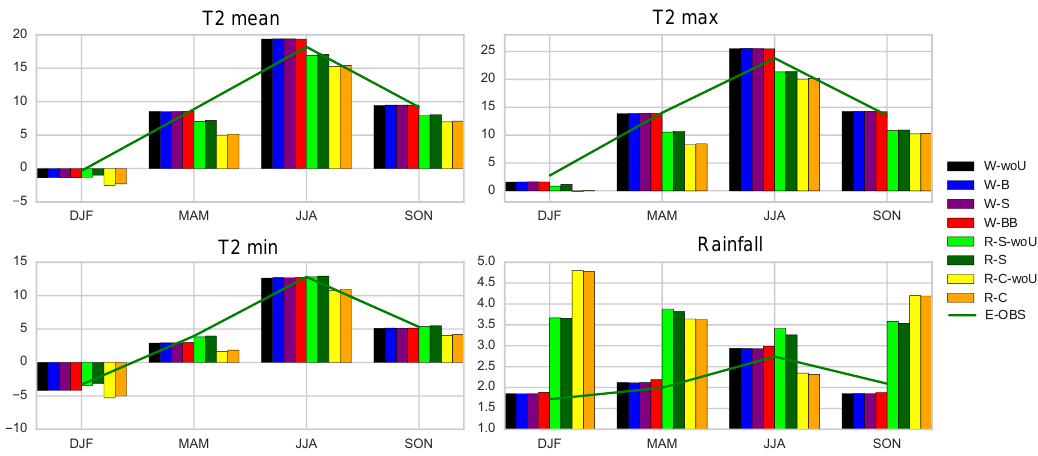
Figure 3. Averaged seasonal modelled temperatures (in ◦ C) and precipitation (mm) for individual model simulations: black – WRF–woU, blue – WRF–BULK, purple – WRF–SLUCM, red – WRF–BEP+BEM, light green – RegCM–SLUCM–woU, dark green – RegCM–SLUCM, yellow – RegCM–CLM4.5–woU, orange – RegCM–CLM4.5. The green curve indicates the seasonal values given by E-OBS.